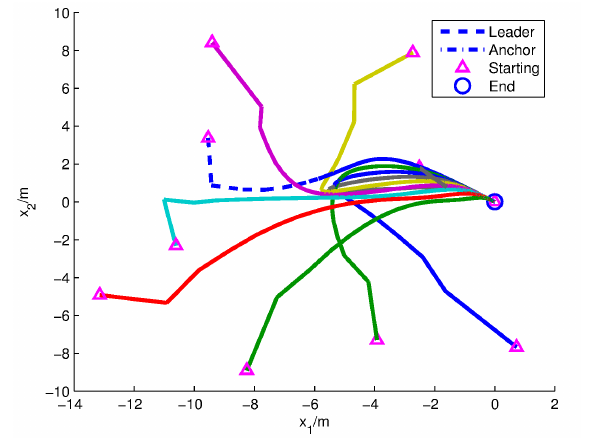
Figure 4. 2D trajectory of mobile